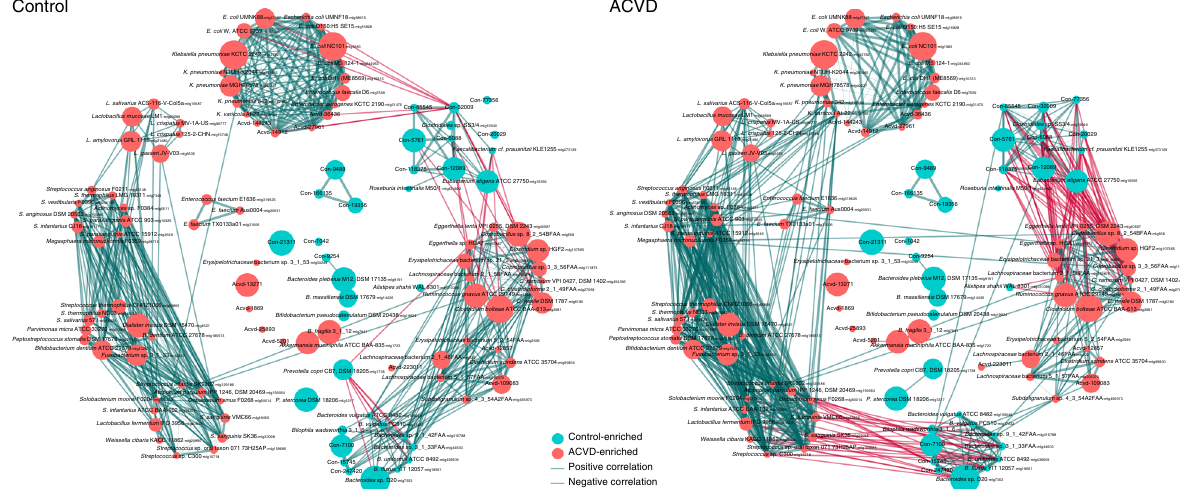
Fig. 2 Co-abundance network of MLGs differentially enriched in individuals with and without ACVD. Left , network in healthy controls ( n = 187); right , network in individuals with ACVD ( n = 218), arranged in the same order. MLGs ( > 100 genes) whose relative abundances were signi fi cantly different between the groups are shown ( q -value < 0.05, FDR-controlled Wilcoxon rank-sum test). Red circles , ACVD-enriched; cyan circles , control-enriched. The size of each circle indicates the number of genes in an MLG (100 – 3723). MLGs not annotated to a known species are shown with their identi fi cation number only. Please see Supplementary Data 3 for more information on taxonomic annotations. Green edges , positive correlations; red edges , negative correlations. The width of the edges decreases with the absolute value of the Spearman ’ s cc: thick edges , | cc | > 0.7; medium , 0.5 < | cc | < 0.7; thin , 0.3 < | cc | <